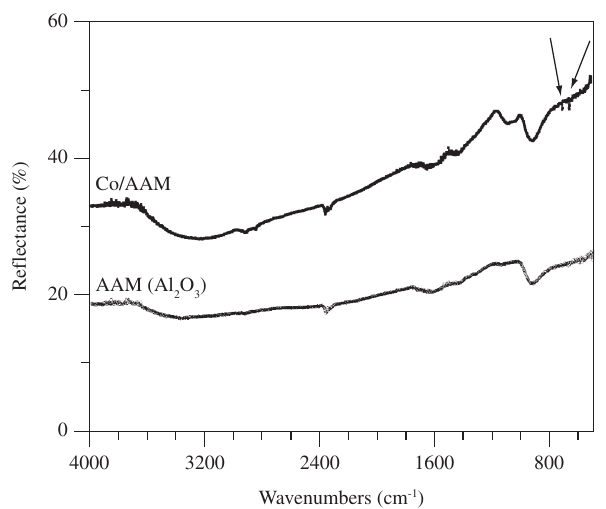
Figure 6. FTIR spectra of AAM and Co/AAM.